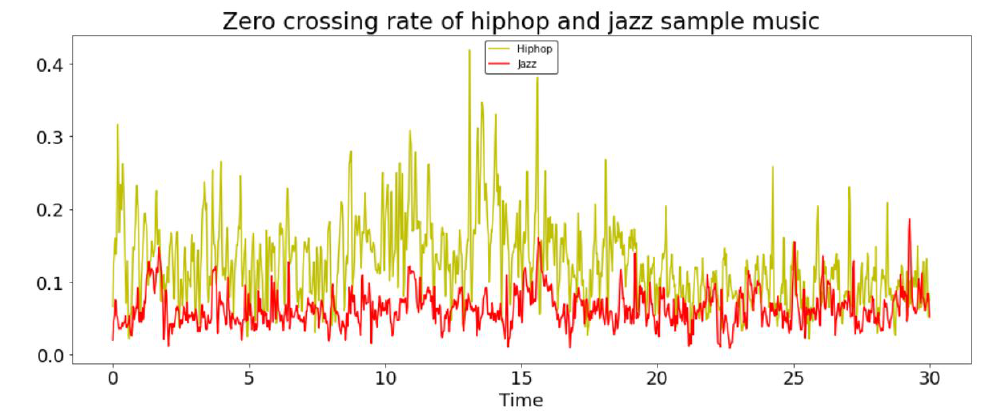
Figure 5. Zero-crossing rate of hip-hop and jazz samples’ music signals. The zero-crossing rate is calculated for the hip-hop and jazz genres’ signals to un- derstand the waveforms of these signals. For example, the total number of zero-crossing rates for the hip-hop genre is two for ten columns because, two times, the hip-hop signal changes from a positive value to zero to a negative value or from a negative value to zero to a positive value; see Figure 6. This feature is very important for research in the field of music information retrieval.